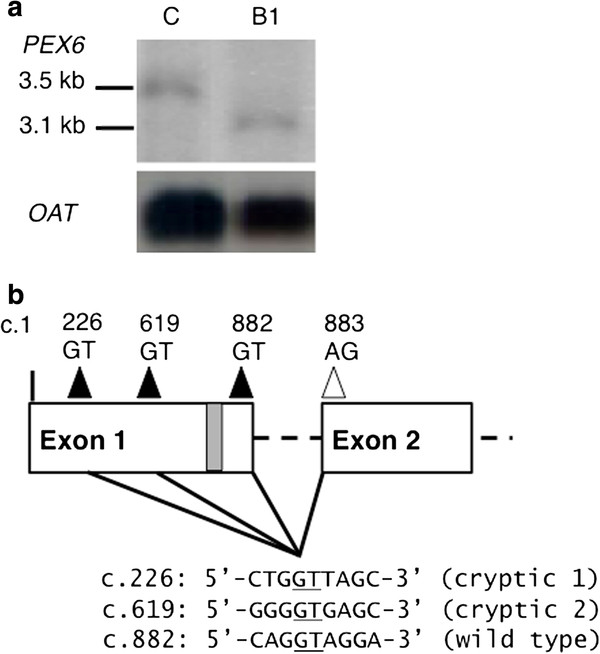
 Use of alternative cryptic donor splice sites in PEX6 c.802_815del mutant cells. (a) Northern blot analysis of fibroblast total RNA of patient B1 compared to control, and (b), graphical representation of PEX6 exon 1 and 2 showing the normal 5’-splice donor (GT) and 3’-splice acceptor (AG) sites, and the two upstream cryptic splice donor sites utilized. Sequences flanking the cryptic and wild type splice donor sites are provided. The grey box represents the c.802_815 deletion